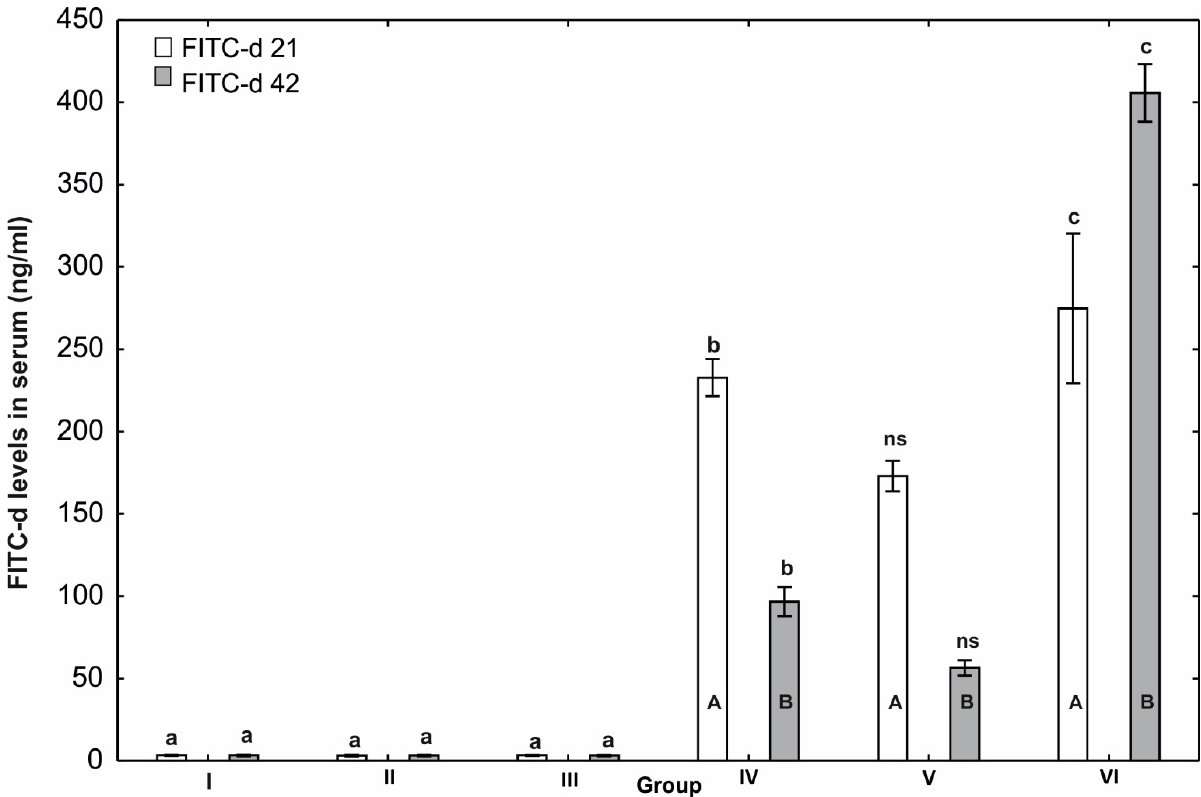
Figure 4. Results of the Kruskal–Wallis one-way ANOVA test (lowercase letters—a, b, c) and the Mann–Whitney U test (uppercase letters—A, B) for FITC-d (fluorescein isothiocyanate dextran) levels in the serum (ng/mL) of chickens at 21 and 42 days of age. Statistical differences ( p ≤ 0.05) are marked with different letters; ns—statistically non-significant differences. Group I (control group)—basal diet; group II—basal diet + 0.5% multi-strain probiotic formulation EM Bokashi ® per tonne of feed + 3% clinoptilolite as a feed additive; group III—basal diet + 0.8% multi-strain probiotic formulation EM Bokashi ® per tonne of feed + 3% clinoptilolite; group IV—basal diet + 0.5% multi-strain probiotic formulation EM Bokashi ® per tonne of feed + 3% clinoptilolite + E. tenella infection; group V—basal diet + 0.8% multi-strain probiotic formulation EM Bokashi ® per tonne of feed + 3% clinoptilolite + E. tenella infection; and group VI—basal diet + E. tenella infection.